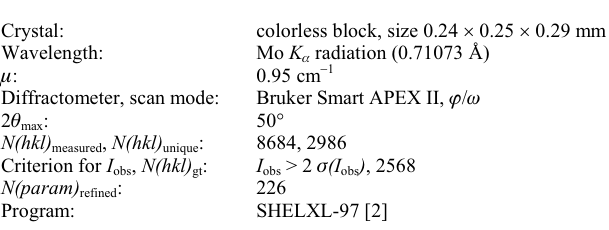
Table 1. Data collection and handling.